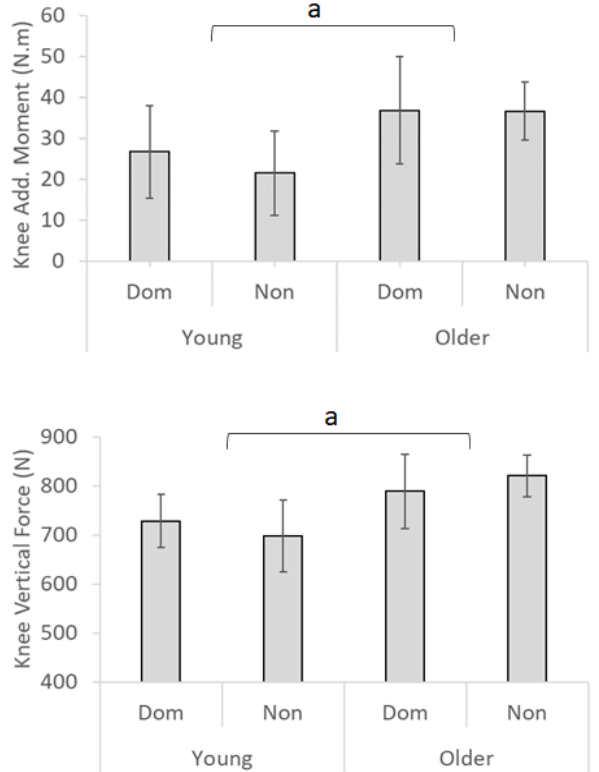
Figure3. Kneejointkinetics: adductionmoment( up )andverticalforce( bottom ); Dom / Non = dominant / non-dominant limb’s values; a = significant ageing e ff ect, l = significant limb e ff